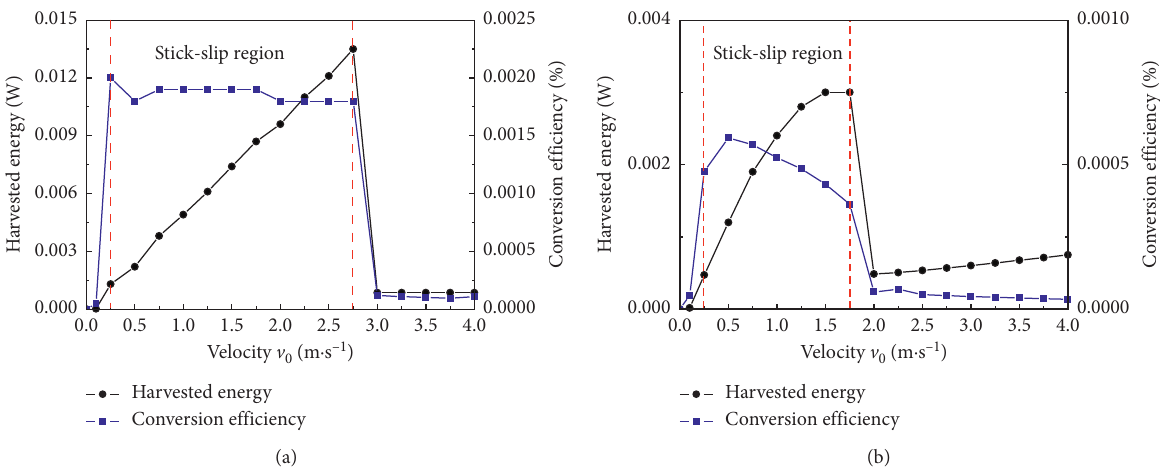
Figure 8: The harvested energy and conversion efficiency of the friction system with different sliding velocities in the friction laws I (a) and II